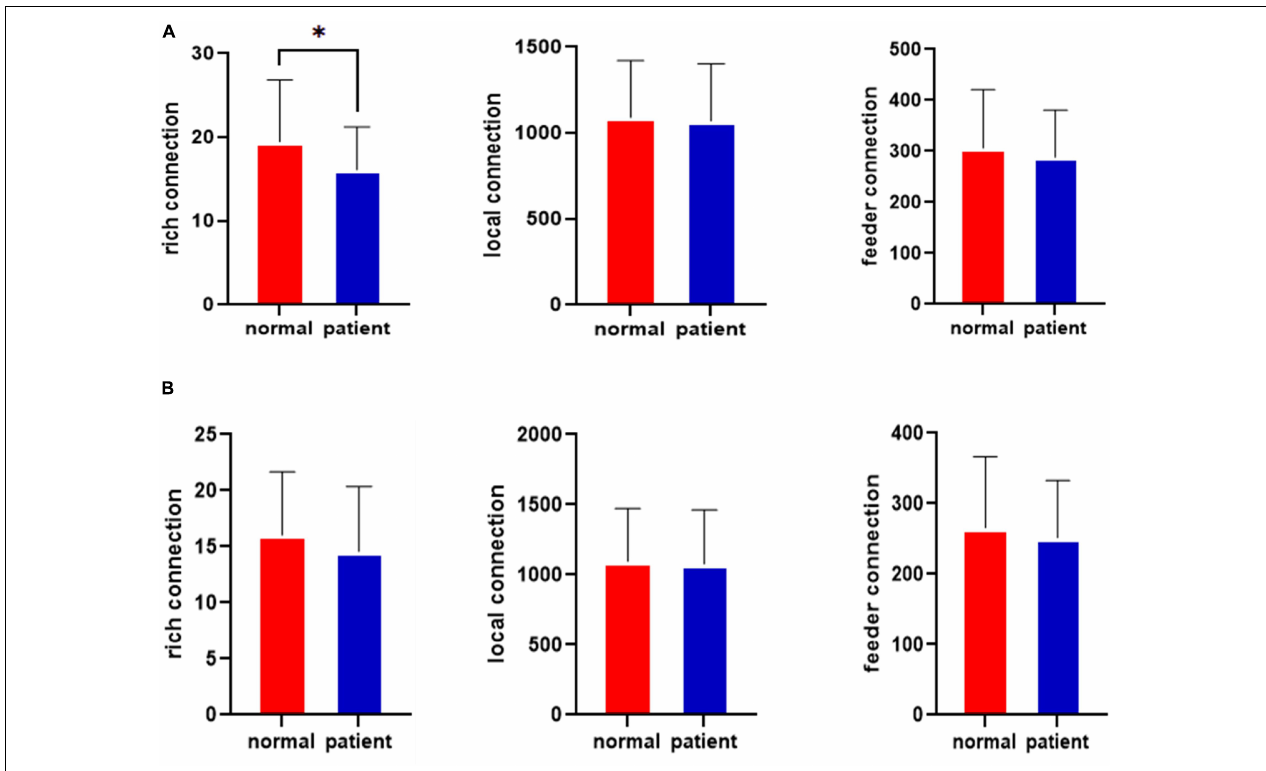
FIGURE 4 | Results for the rich-club junctions in the healthy control group and the JME group. (A) Results for the rich-club junctions before the attacks. (B) Results for the rich-club junctions after the attacks. ∗ p < 0.05, FDR-corrected.